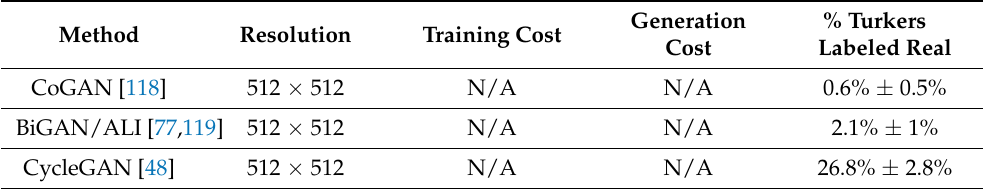
Table 3. Performance of different data synthesis methods for aerial maps, photo to map, the higher percent of Turkers that classify the output as real, the better.